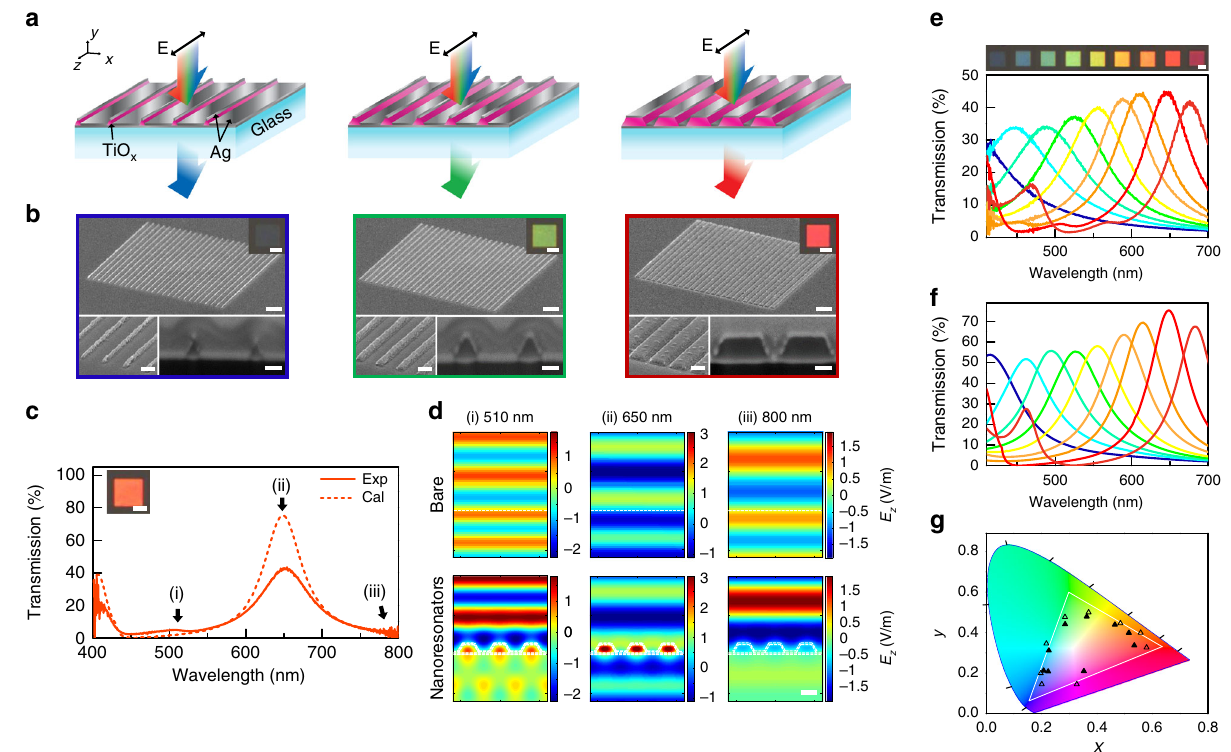
Fig. 1 Color pixels from scattering-reducing nanoresonators. a Schematic of color pixels based on arrays of nanoresonators consisting of TiO x nanowires enclosed by Ag layers. For normally incident s-polarized white light, each pixel transmits a distinct color determined by the nanoresonator width. The period is constant for all pixels. b From left to right, SEM images of blue, green, and red color pixels of increasing nanoresonator width but fi xed period, acquired at a 63° tilt angle. Scale bar is 1 µ m. Inset: OM images, SEM images of an enlarged view and FIB cross-sections of each pixel. Scale bar is 5 µ m, 200 nm and 100 nm, respectively. c Measured and calculated transmission spectra of an orange pixel with nanoresonator width of 280 nm. Inset shows OM image and scale bar is 5 µ m. d Calculated z -component of electric fi eld distribution for bare glass substrate (top row) and for pixel from ( c ) (bottom row) at resonant (650 nm, middle column) and off-resonant (510 and 800 nm, left and right column, respectively) wavelengths. Scale bar is 200 nm. e OM images and measured transmission spectra of a pixel set, covering the full visible range. Scale bar is 5 µ m. f Simulated transmission spectra of the pixel set. g CIE chromaticity diagrams of the pixel set. Solid and hollow triangles represent chromaticities derived from the measured and simulated transmission spectra, respectively. The white triangle depicts the sRGB color triangle. The deposited TiO x fi lm thickness is 115